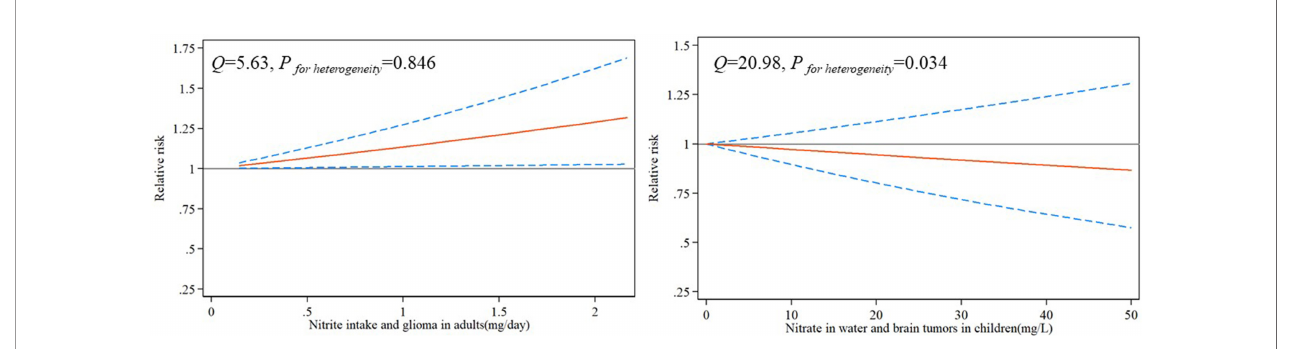
FIGURE 4 | Risk between nitrite/nitrate and glioma estimates from dose-response meta-analysis.